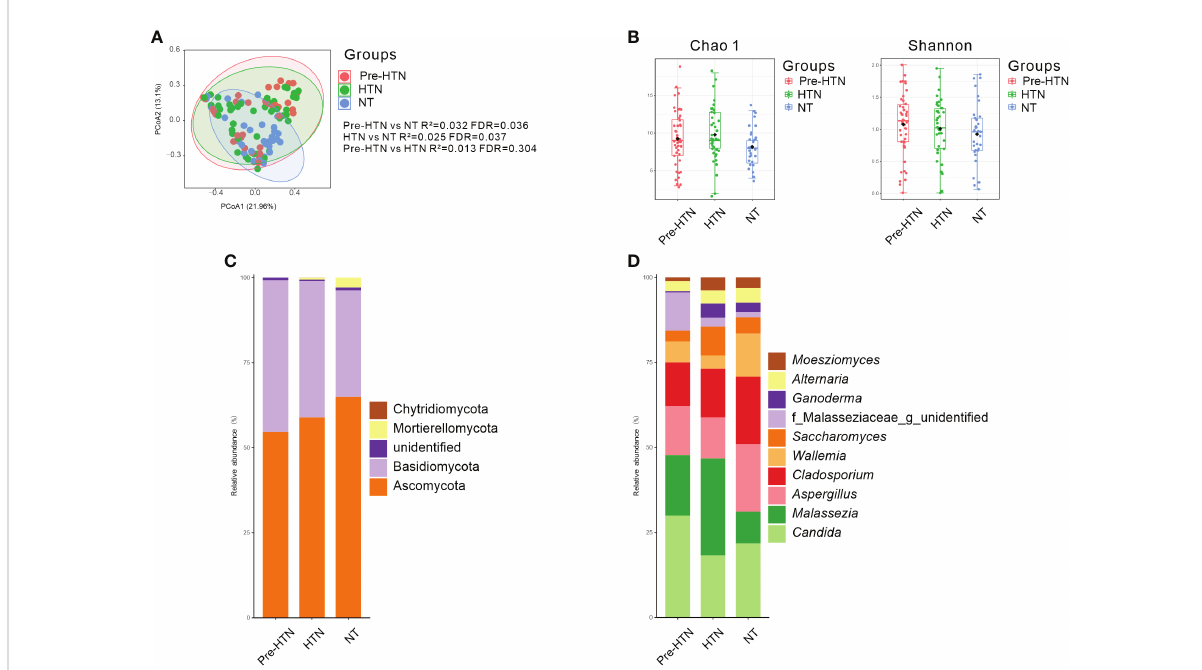
FIGURE 1 Bacterial composition, Venn, bacterial diversity, and phylum and genus composition in the urine from subjects of pre-HTN, HTN and NT. (A) PCoA based on Bray-Curtis distances ASV level was performed to compare microbial community among groups of pre-HTN, HTN and NT. The 95% con fi dence ellipse is drawn for each group. Permutational multivariate analysis of variance (PERMANOVA) was performed for statistical comparisons of samples in the two groups. P value was adjusted by the Benjamini and Hochberg false discovery rate (FDR). (B) Bacterial richness and diversity measured by Chao 1 and Shannon index were calculated at ASV level. Wilcoxon rank-sum test was performed and adjusted by Benjamini and Hochberg false discovery rate (FDR). (C, D) Fungal pro fi le at the phylum and genus level. Only the top 10 most abundant genus are shown. HTN, hypertension; NT, normotension; pre-HTN,